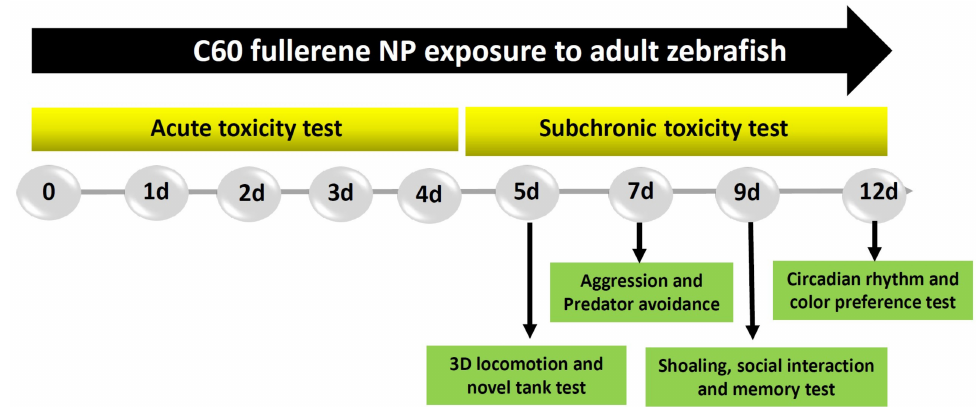
Figure 1. Overview of the experimental design and time points for a sub-chronic toxicity test for carbon 60 nanoparticles (C 60 NPs) in adult zebrafish. For sub-chronic toxicity, we measured 3D (three-dimensional) locomotion, novel tank exploration, aggression, predator avoidance, social interaction, shoaling, memory, circadian rhythm, and color preference test at specific time points as indicated by the arrowheads. There was no mortality in the whole exposure